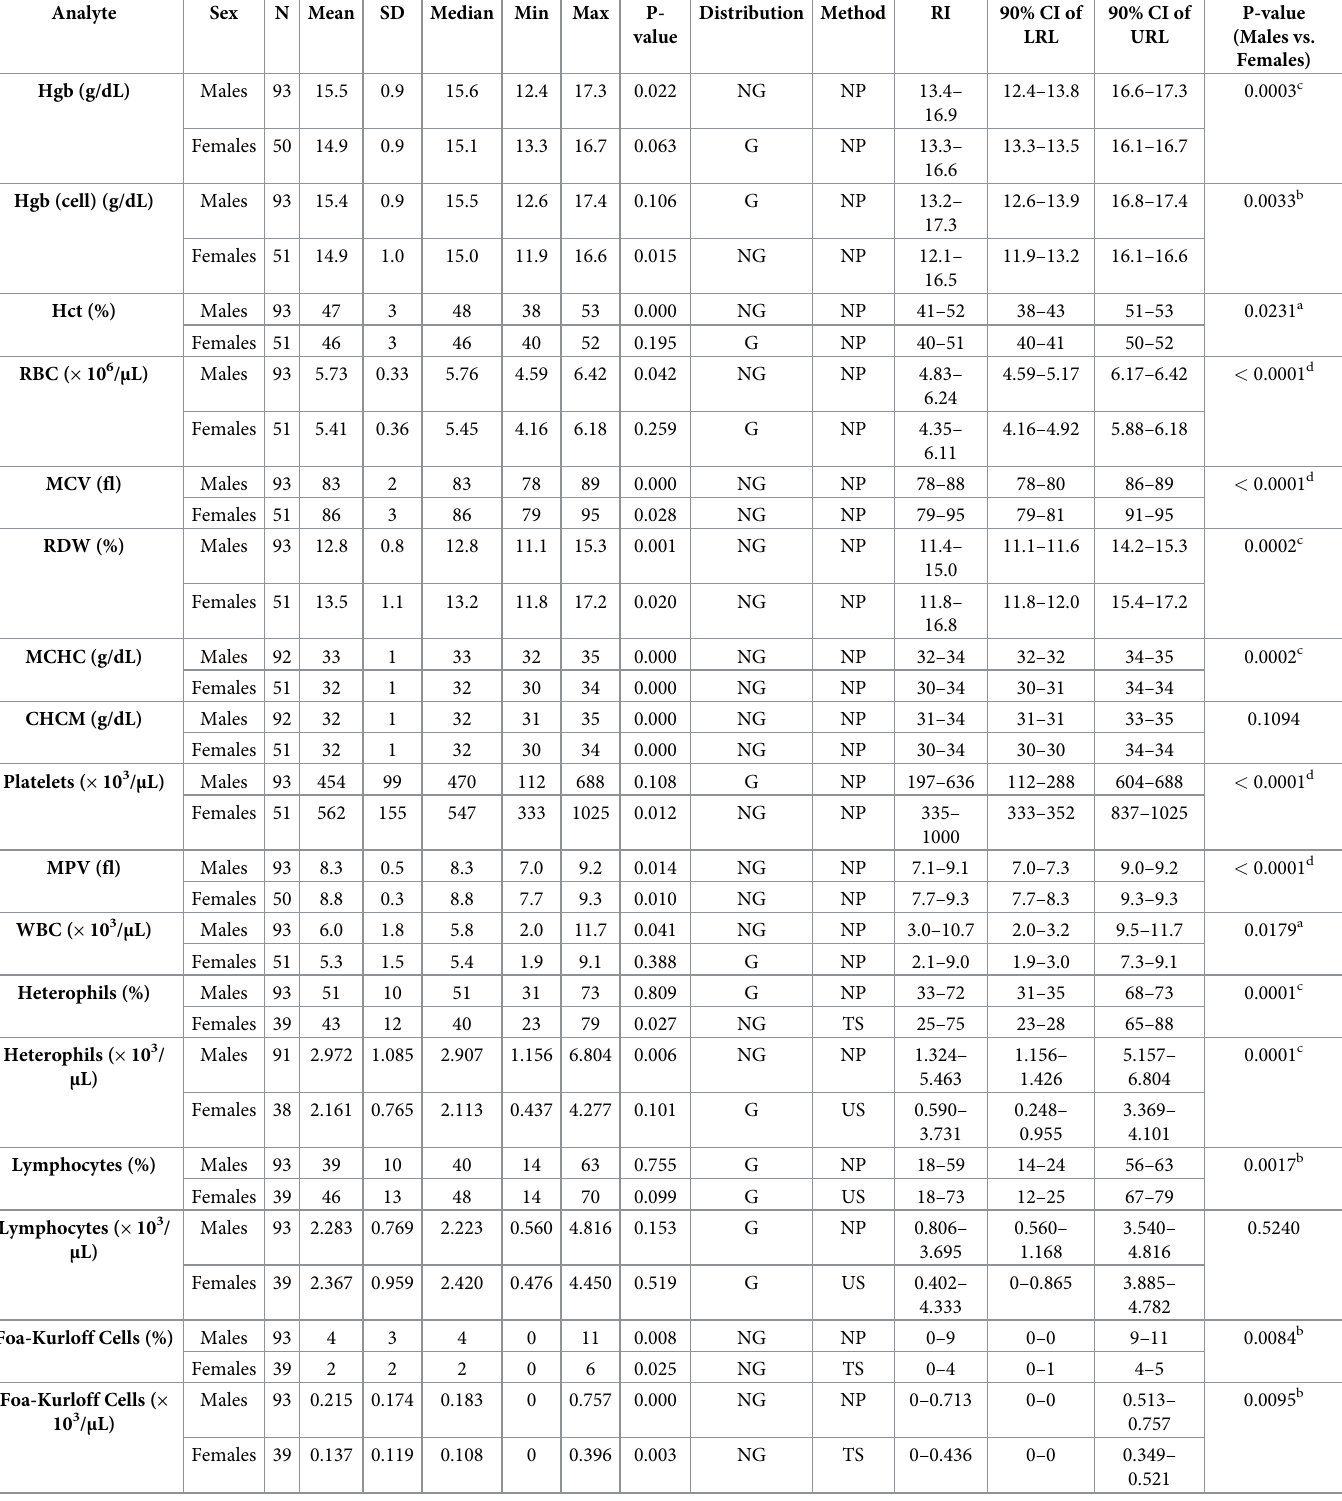
Table 3. Summary data and reference intervals for hematology parameters of adult male and female Hartley guinea